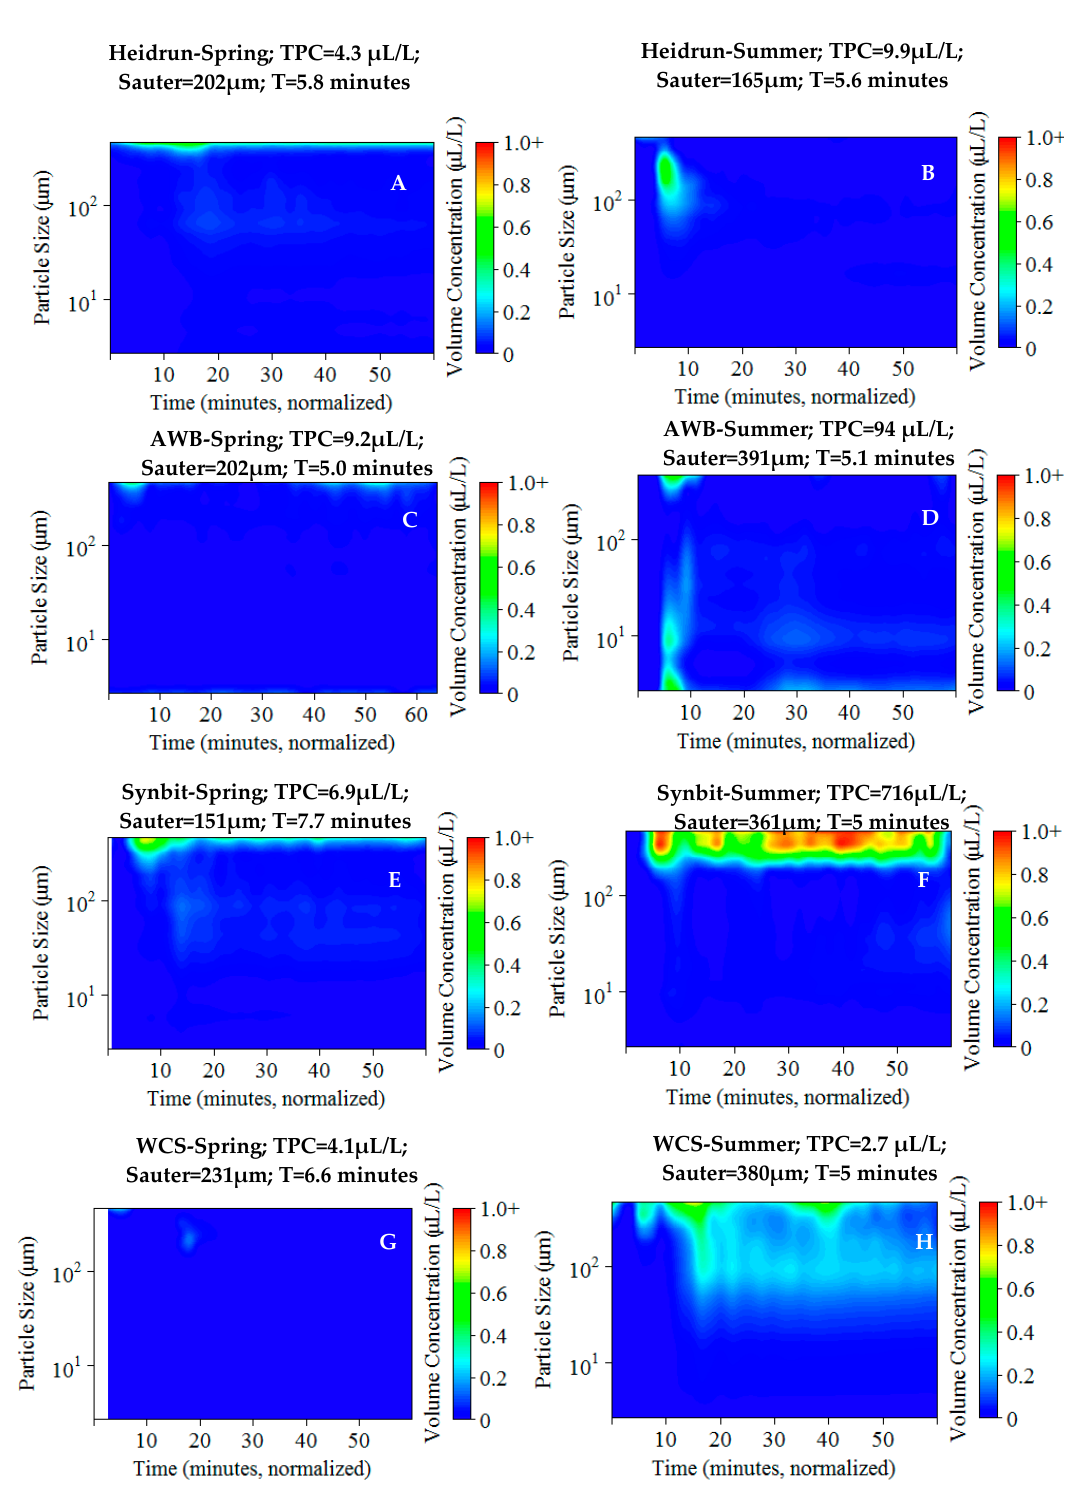
Figure 2. Contour plots (LISST data, 12 m from oil release) showing seasonal effects on the concentration of oil particle size simulated in the wave tank for the natural dispersion of: ( A ) Heidrun-spring, ( B ) Heidrun-Summer, ( C ) AWB-Spring, ( D ) AWB-Summer, ( E ) Synbit-Spring, ( F ) Synbit-Summer, ( G ) WCS-Spring, and ( H ) WCS-summer. The Sauter mean diameter values varied between 150 to 350 µm and low concentration of small particles (<100 µm) were detected in all cases.